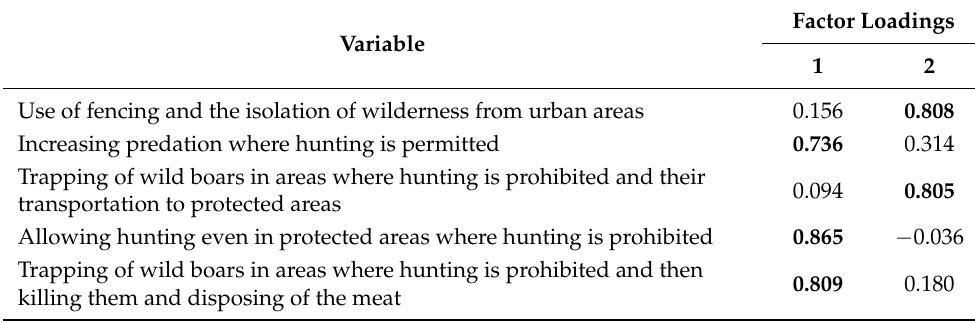
Table 2. Factor loadings after rotation (bold numbers show the factor that belongs to each